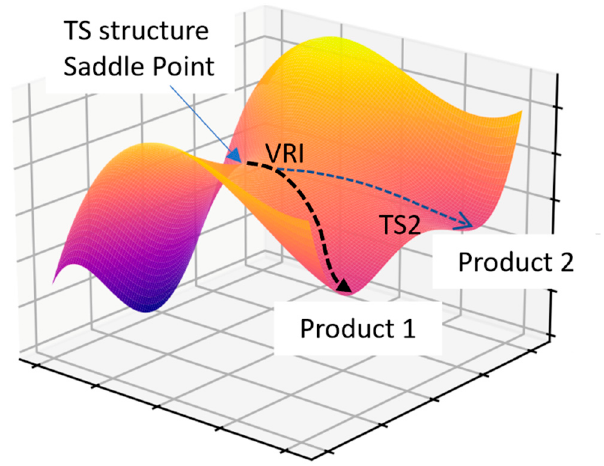
Figure 12. Bifurcation in PES. The PES is generated from the model potential provided by Collins et al. [ Error! Reference source not found. ].